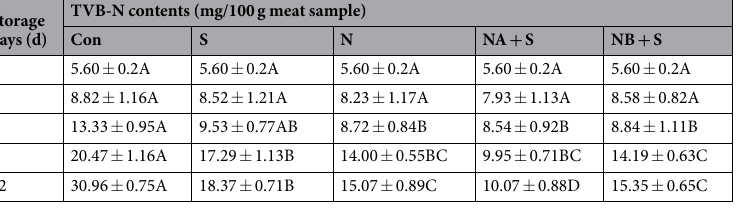
Table 2. TVB contents in the samples treated with different antibacterial substances during storage. a Values are averages ± standard deviations. Different uppercase letters in a row indicate significant difference (p < 0.05). b Con: control sample, no SlpB/nisin added; S: SlpB 40 μ g/g; N: nisin 0.5 mg/g; NA + S: nisin 0.5 mg/g plus